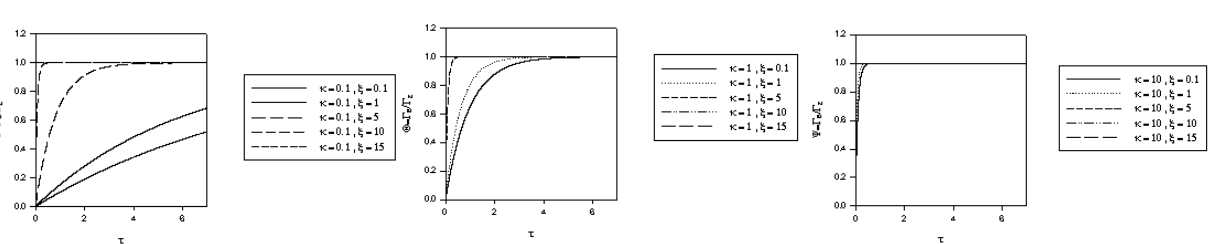
various values of κ and normalized potential ξ